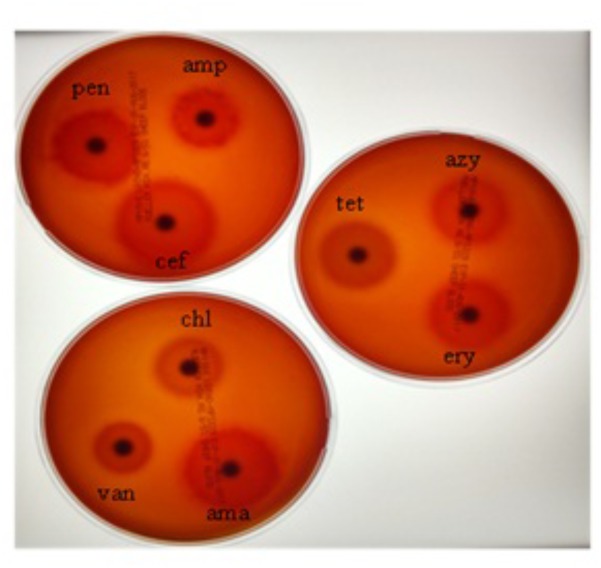
Antibiotics susceptibility test in Streptococcus pyogenes NBMKU12 isolate. Pen, penicillin; amp, ampicillin; cef, ceftriaxone; chl, chloramphenicol; van, vancomycin; ama, amoxiclav; tet, tetracycline; ery, erythromycin; azy, azithromycin.